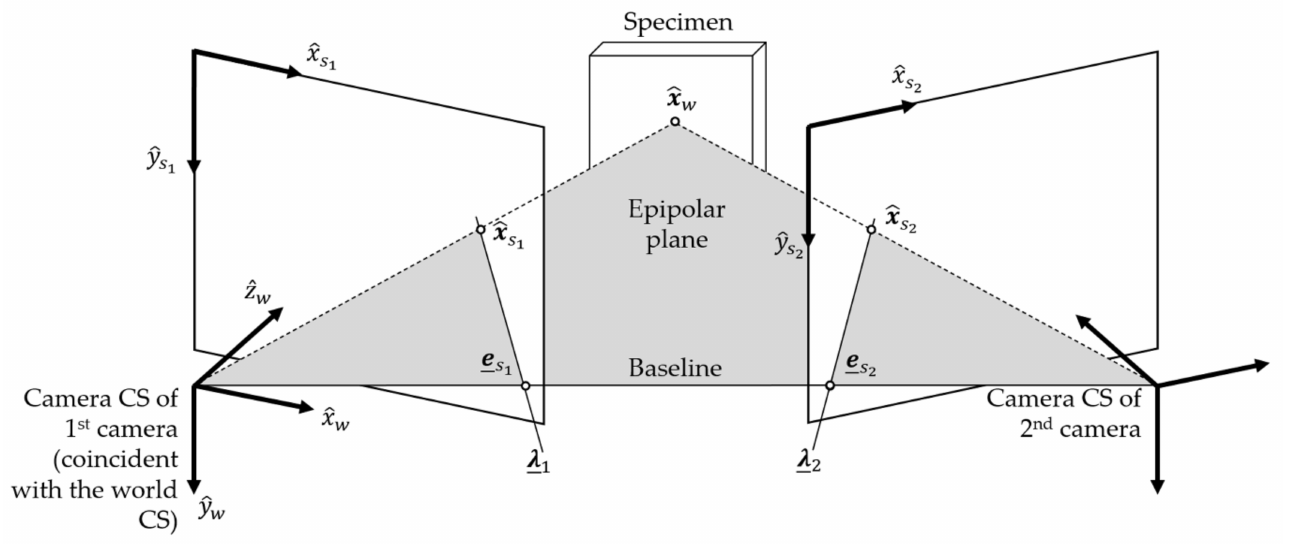
Figure 2. Schematic illustration of the epipolar